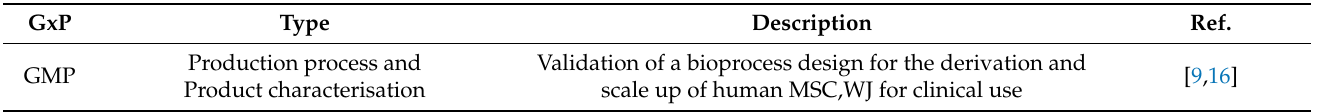
Table 1. List of studies conducted in the development of experimental MSC,WJ-based therapy for the treatment of traumatic spinal cord injury. Compliance with specific quality standards is described in the left column. GxP = compliance with Good Scientific Practices; GLP = Good Laboratory Practice; GMP = Good Manufacturing Practice; GCP = Good Clinical Practice; PD = Pharmacodynamics; PK = Pharmacokynetics; SCI = Spinal Cord Injury. GxP Description Ref. Production process and Validation of a bioprocess design for the derivation and Product characterisation scale up of human MSC,WJ for clinical